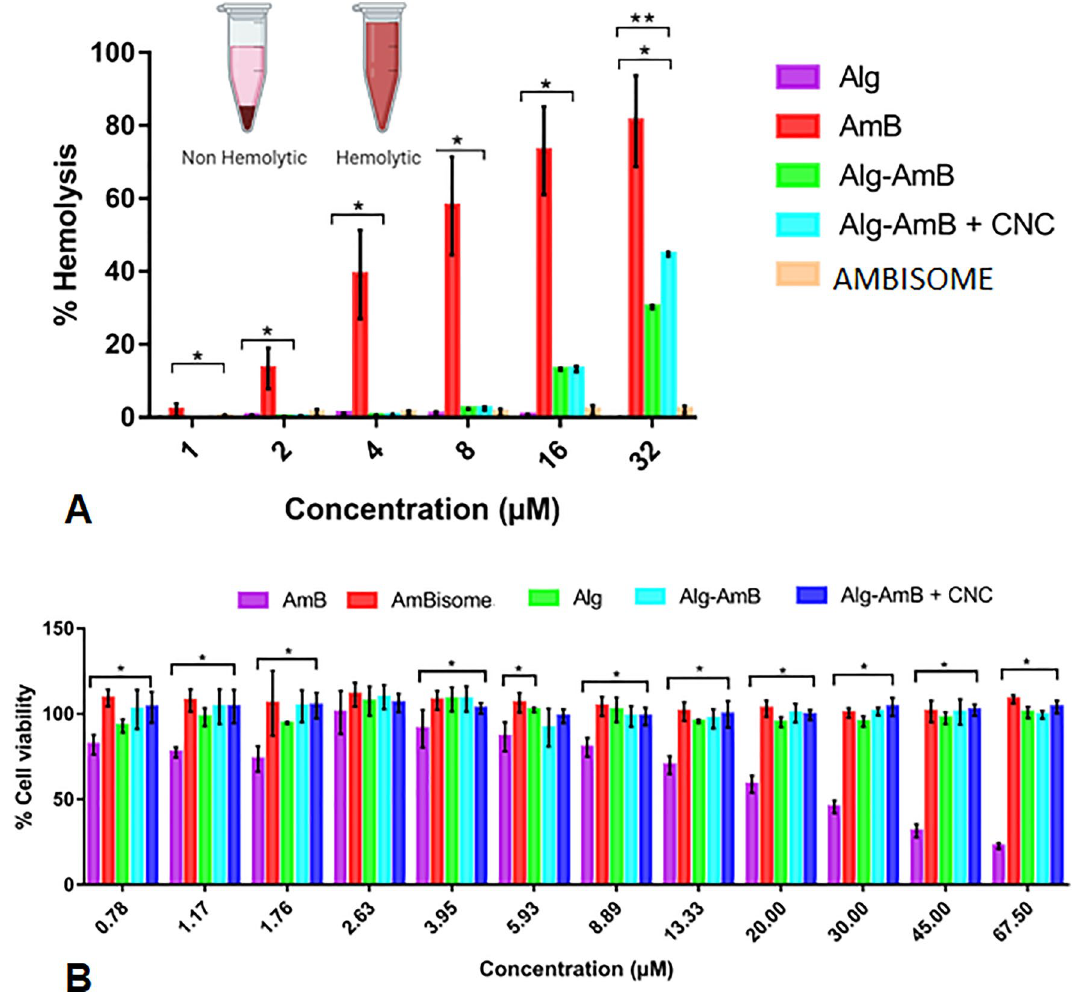
Figure 2. Percentage of hemolysis after treatment of red blood cells ( A ) Cytotoxicity of the renal cell line HEK293T ( B ) with Alg, Alg-AmB, Alg-AmB + CNC, AMBISOME and AmB. Note: A AmB (*) and Alg-AmB (**) were compared to the other groups by the Duncan test (p < 0.05). B – AmB (*) was compared to the other groups by the Duncan test (p <